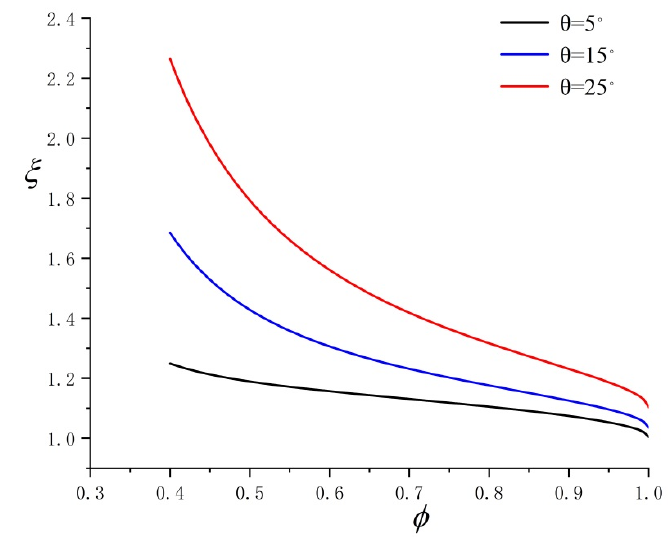
Figure 8. Influence of different values of θ on tortuosity.